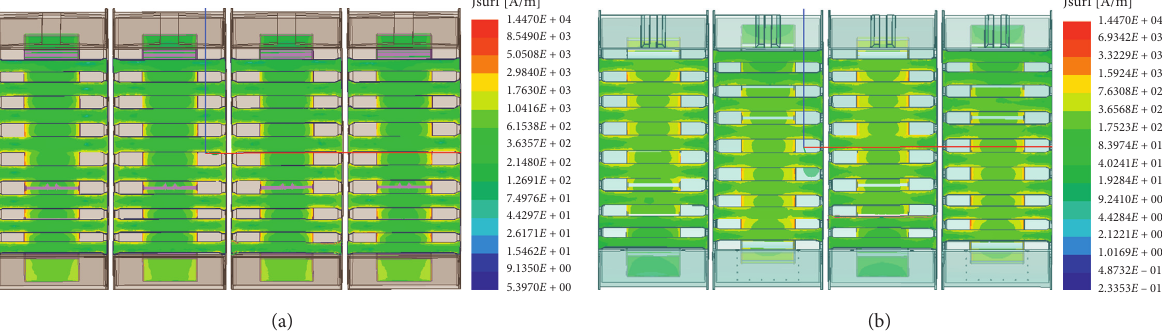
Figure 8: Normalized J density distribution of the two versions of the antenna at (0, 0, 0, 0) and 30MHz before optimization (a) and after optimization (b).